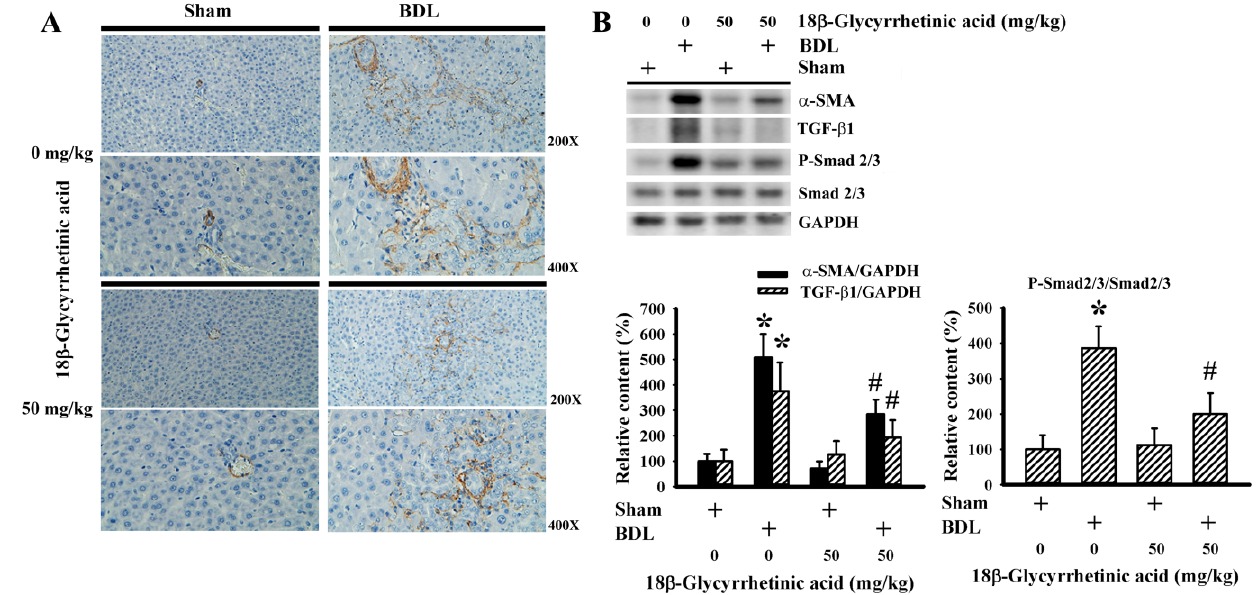
Figure 6. 18 β -Glycyrrhetinic acid alleviated BDL-induced fibrotic signaling in the treatment study. ( A ) The paraffin-embedded liver tissues were subjected to immunohistochemical examination with anti- α -SMA antibody. Representative photomicrographs of α -SMA immunoreactivity are shown. Original magnification is 200 × and 400 × . ( B ) Protein contents in liver tissues were measured using Western blot with indicated antibodies. Representative blots and the quantitative data are shown. * p < 0.05 vs. the sham vehicle group and # p < 0.05 vs. the BDL vehicle group, n = 8.